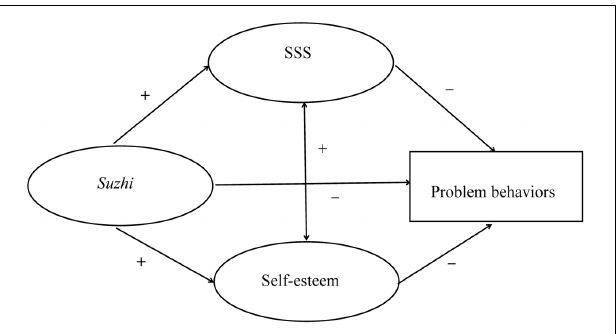
FIGURE 1 | Model of the hypothesized mediator role of SSS and self-esteem in the relationship 164 between psychological suzhi and problem behaviors.